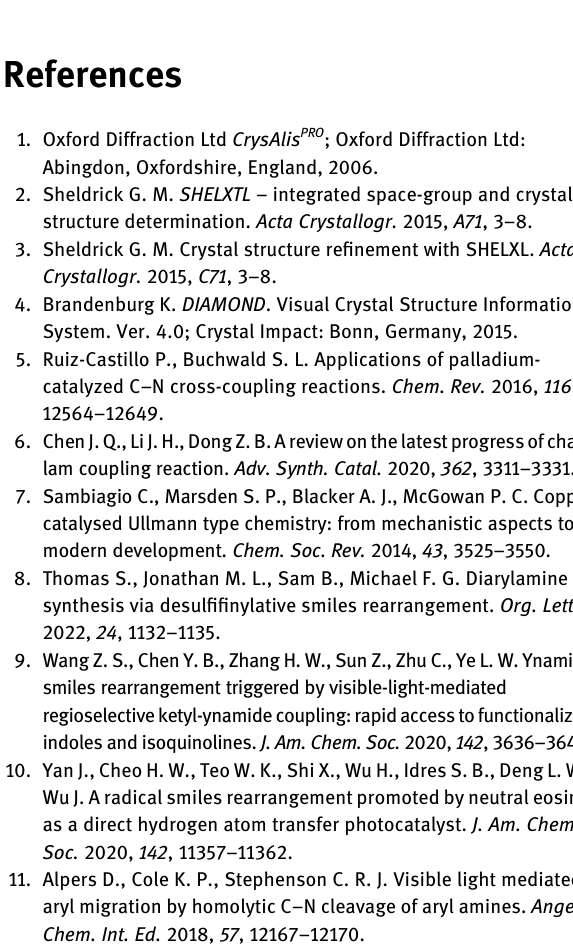
There is one molecule in the asymmetric unit ofthe title structure which is shown in the figure. The p-methyliodo- phenyl group is attached to the 4-position of the ethyl benzoate. The C – N bond distance is 1.443(3) Å for C7 N1, which is normal for arylamine. The three bond angles around the amino group are 123.8(2) ° for C7 — N1 — C8, 111.2(2) ° for C4 — C7 — N1 and 119.0(2) ° for N1 — C8 — C13, respectively. The dihedral angel between the benzene rings … is 57.7(8) ° . Molecules are linked by N — H O hydrogen bonds to form one-dimensional chain-like supramolecular structure. These chains are linked by C — H – π interactions with the distance of 2.771 Å for hydrogen (H3) atom to the nearest carbon (C9) atom.